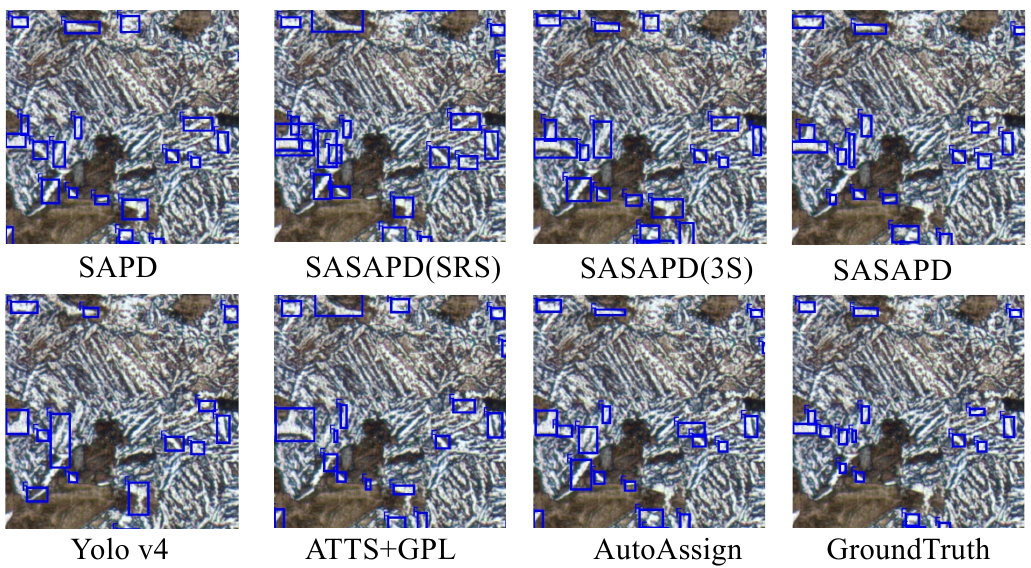
Figure 10. The visual comparison of identifying ferrite (F) on dataset